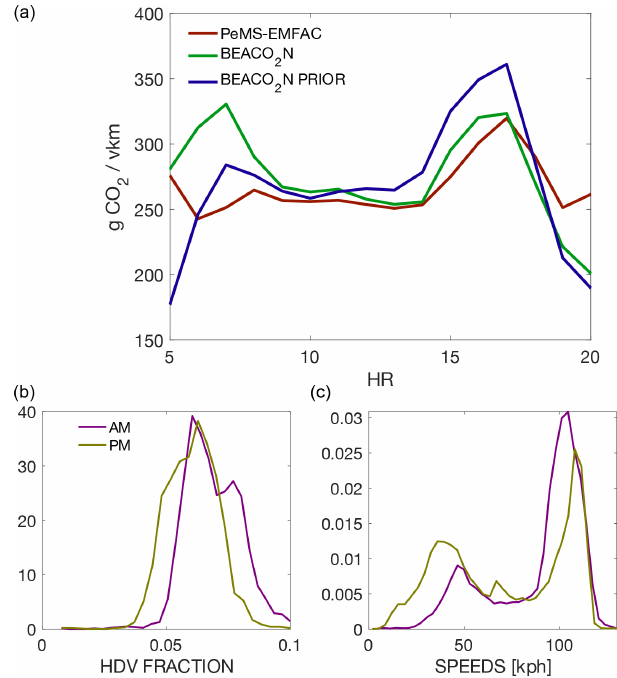
Figure 4. (a) Emission rates by time of day on weekdays for PeMS- derived (red), BEACO2N prior (blue), and BEACO 2 N posterior (green) data. Probability density functions of the HDV (truck) frac- tion (b) and speed (c) from a weekday morning (05:00–09:00) and evening (16:00–20:00) rush hour period on the segment of Interstate 80 analyzed in Sect. 3. The y axis represents the relative probability of the HDV fraction (b) or averaged hourly speed (c) . Speeds are from individual PeMS sensors, whereas the HDV fraction is aggre- gated over the whole stretch under consideration (both